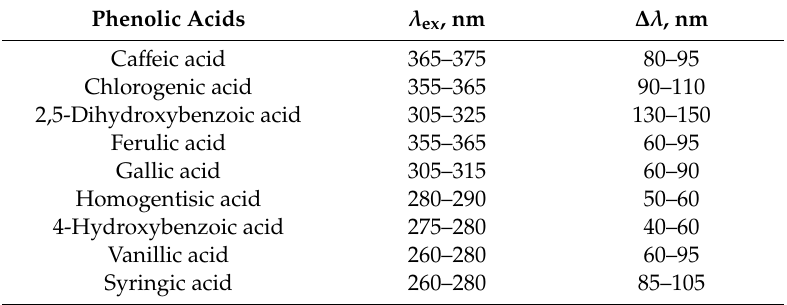
Table 6. The emission and excitation wavelengths of selected phenols